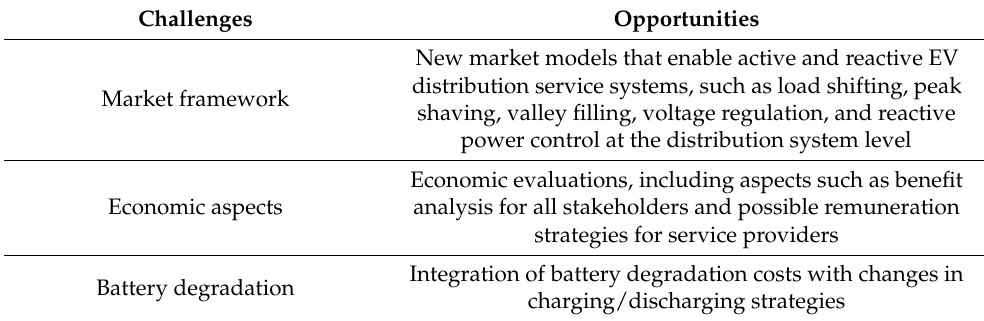
Table 2. Summary of challenges and opportunities of application of smart power distribution for EVs [59]. Challenges Opportunities New market models that enable active and reactive EV distribution service systems, such as load shifting, peak Market framework shaving, valley filling, voltage regulation, and reactive power control at the distribution system level Economic evaluations, including aspects such as benefit Economic aspects analysis for all stakeholders and possible remuneration strategies for service providers Integration of battery degradation costs with changes in Battery degradation charging/discharging